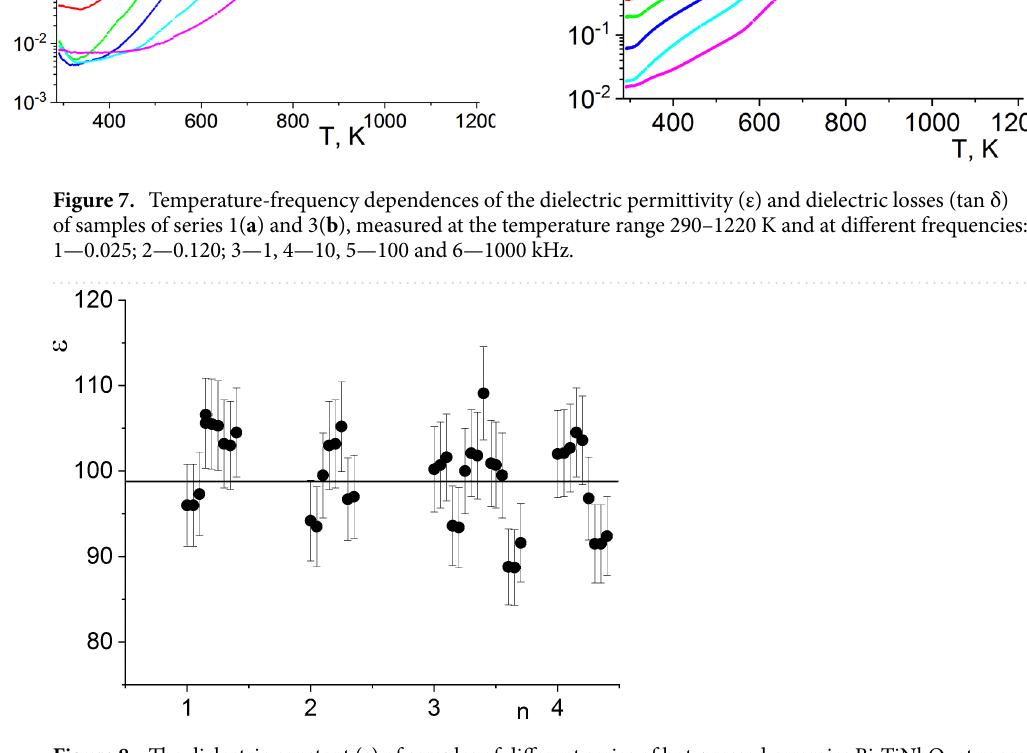
Figure 8. The dielectric constant (ε) of samples of different series of hot-pressed ceramics Bi 3 TiNbO 9 at room temperature, measured at a frequency of 1 kHz (the horizontal line indicates the average value ε = 98.8 for all measurements). Sample modifications: (1) an intact Bi 3 TiNbO 9 powder (2) Bi 3 TiNbO 9 powder treated with 36.7% ethyl alcohol; (3) Bi 3 TiNbO 9 powder treated with Bi 3 TiNbO 9 UHDs; (4) Bi 3 TiNbO 9 powder treated with lactose